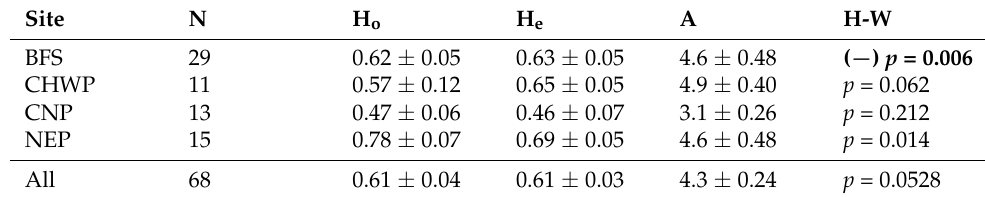
Table 2. Measures of genetic variation in four sampling sites averaged across seven